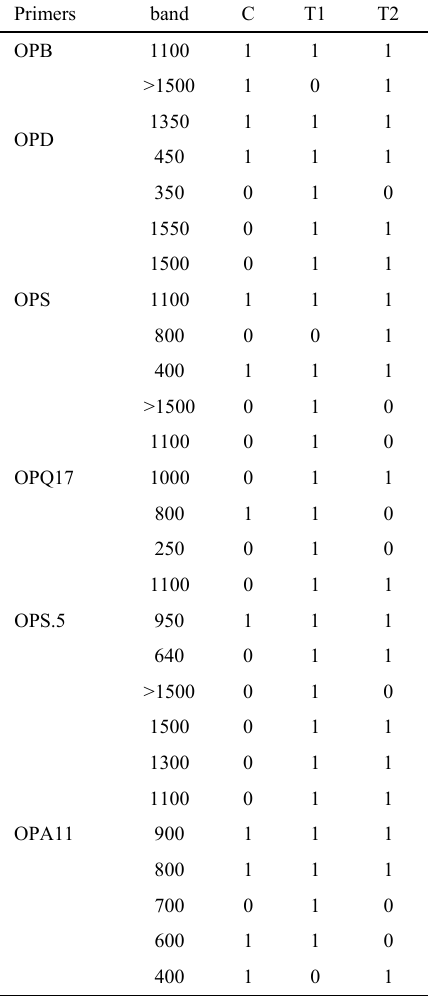
Table 1: Results of banding related to primers of Fig. 2